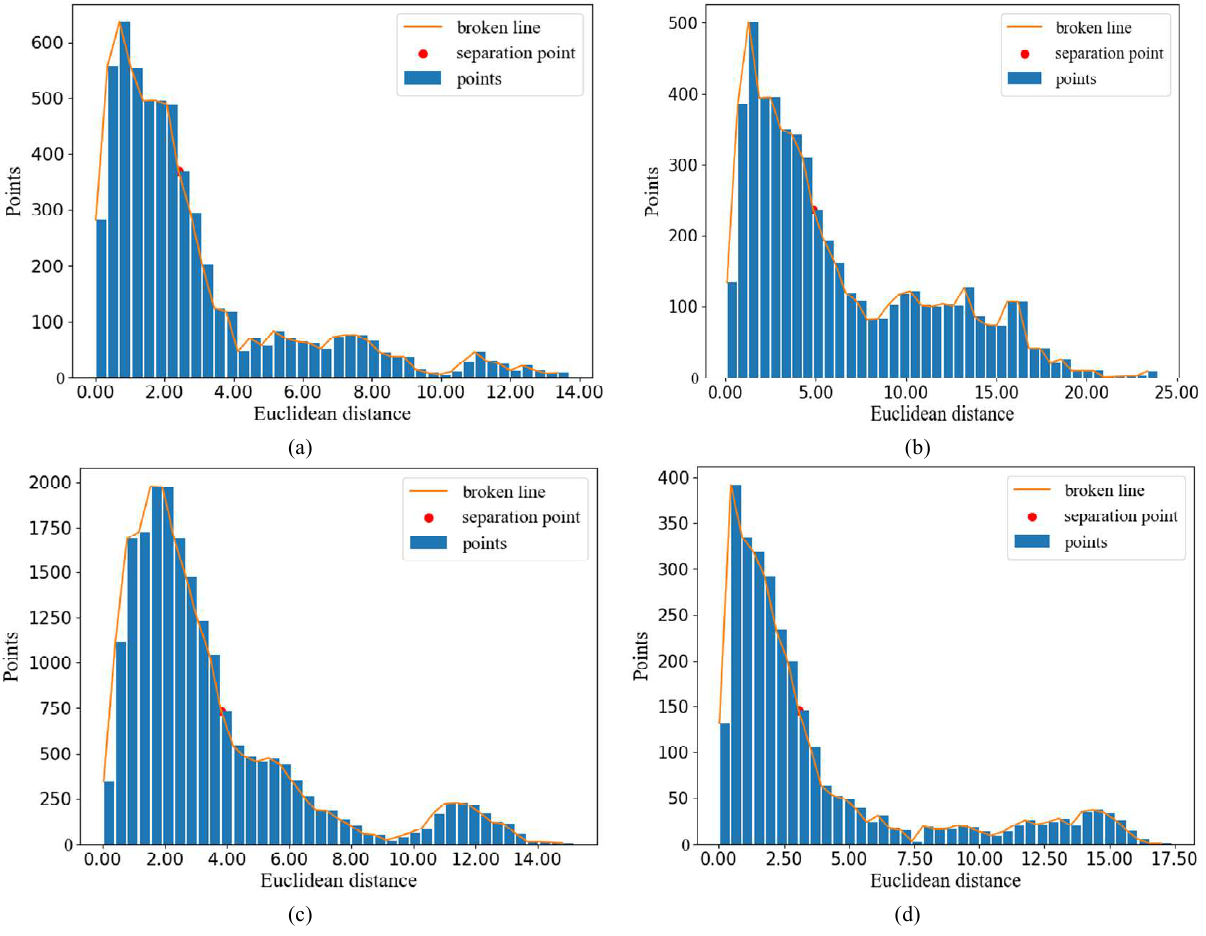
Figure 9. Points–distance line charts of four samples. ( a ) Sample 1 of Figure 6a; ( b ) Sample 2 of Figure 6b; ( c ) Sample 3 of Figure 6c; ( d ) Sample 4 of Figure 6d.